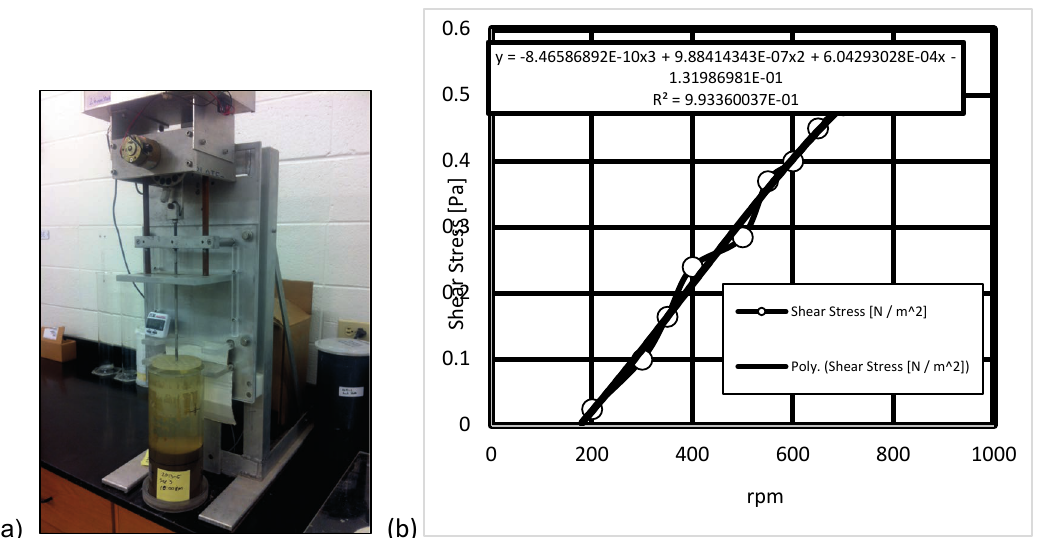
y = -8.46586892E-10x3 + 9.88414343E-07x2 + 6.04293028E-04x - 1.31986981E-01 R² =